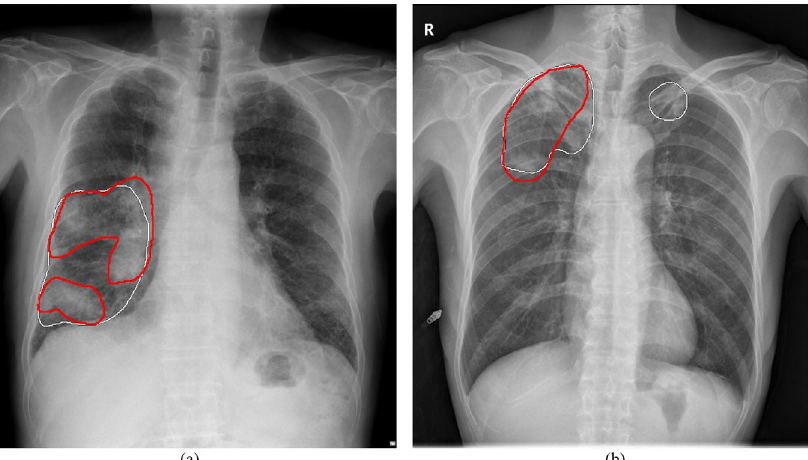
Fig. 3 Examples of CAD predictions on chest radiographs. a Closely located and diffuse lesions are predicted as a single large lesion, and b dense bone structures such as the intersection of the rib and clavicle or sternum were falsely identi fi ed as consolidation. CAD Computer- aided detection